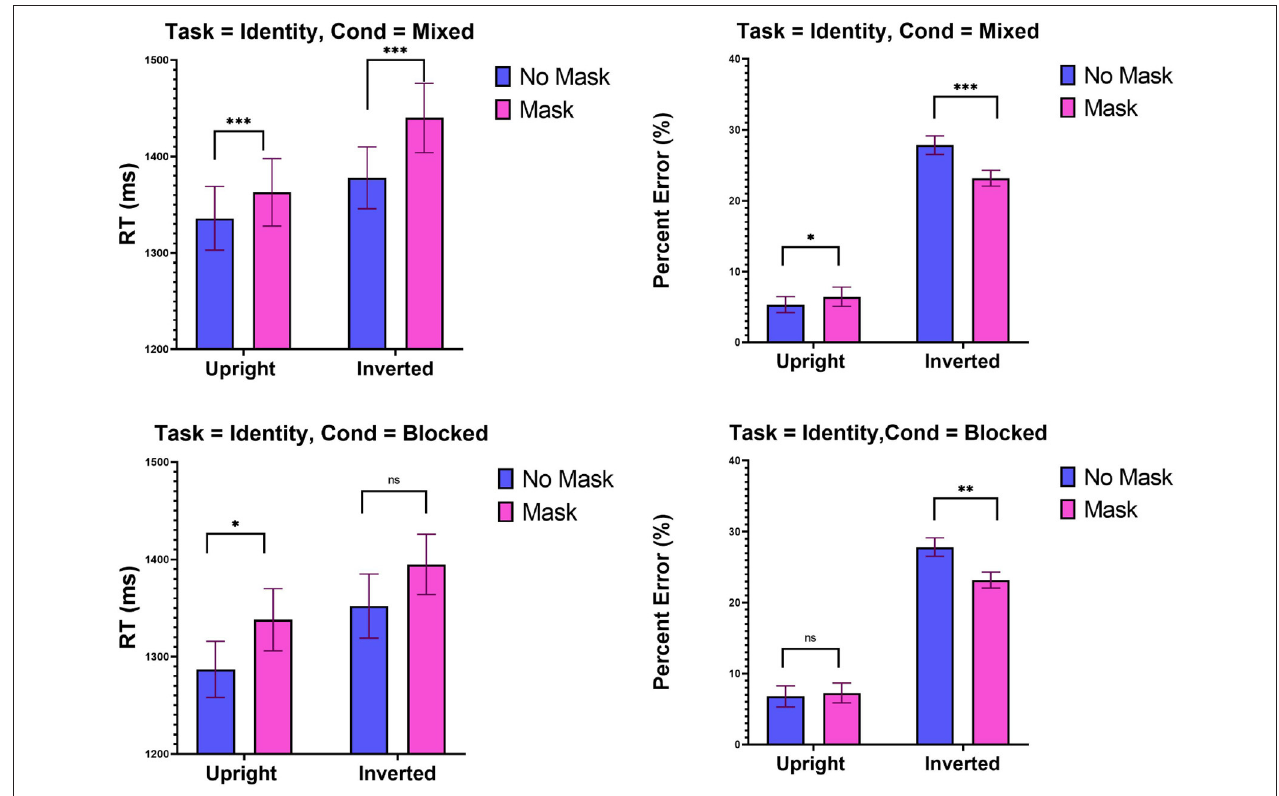
FIGURE 2 | Experiment 1: Mean RTs (ms) and percent error (%) as a function of mask (mask and no mask) and inversion (upright and inverted). Top panel: Mixed condition, bottom panel blocked condition. *** p < 0.001, ** p < 0.01, and * p < 0.05. Error bars are standard errors of the means.